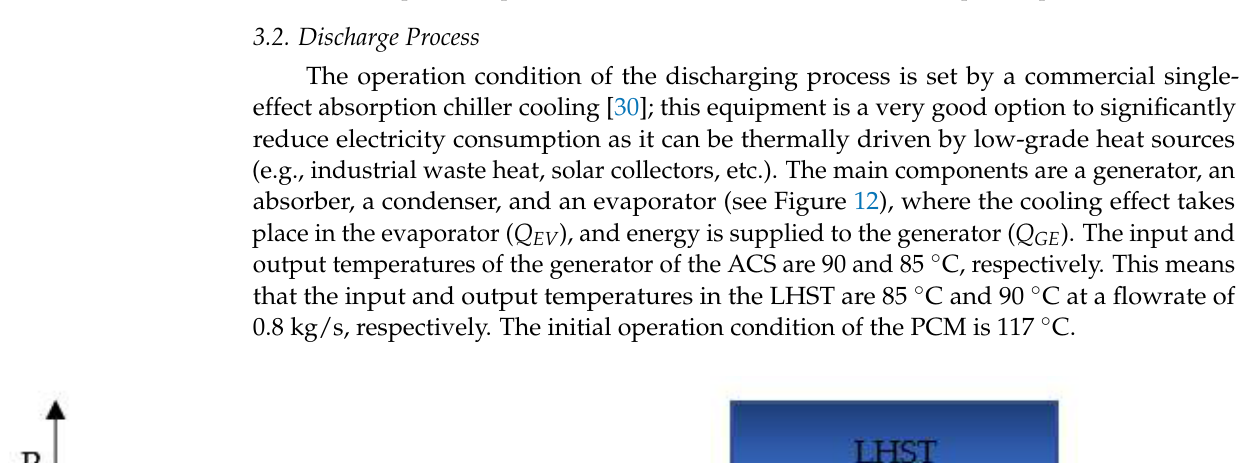
Figure 11. Temperatures profiles in the center of the PCM at different input temperatures of the HF.